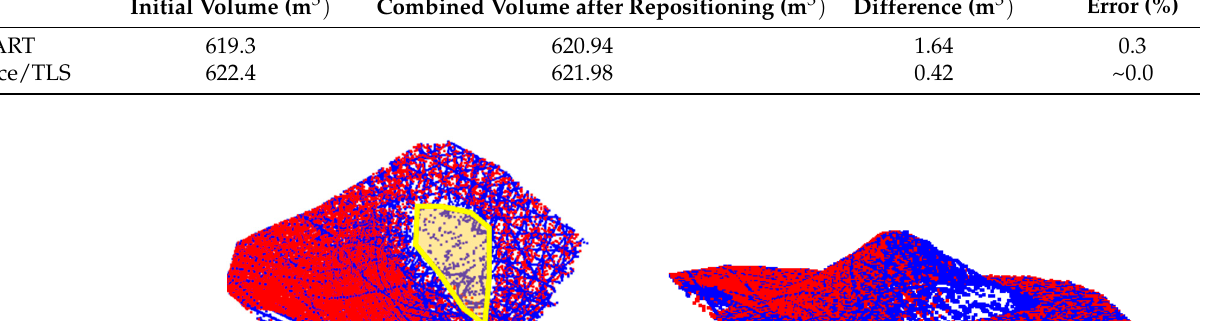
Table 8. SMART and TLS volumes estimated for post-repositioned stockpiles on the right side.